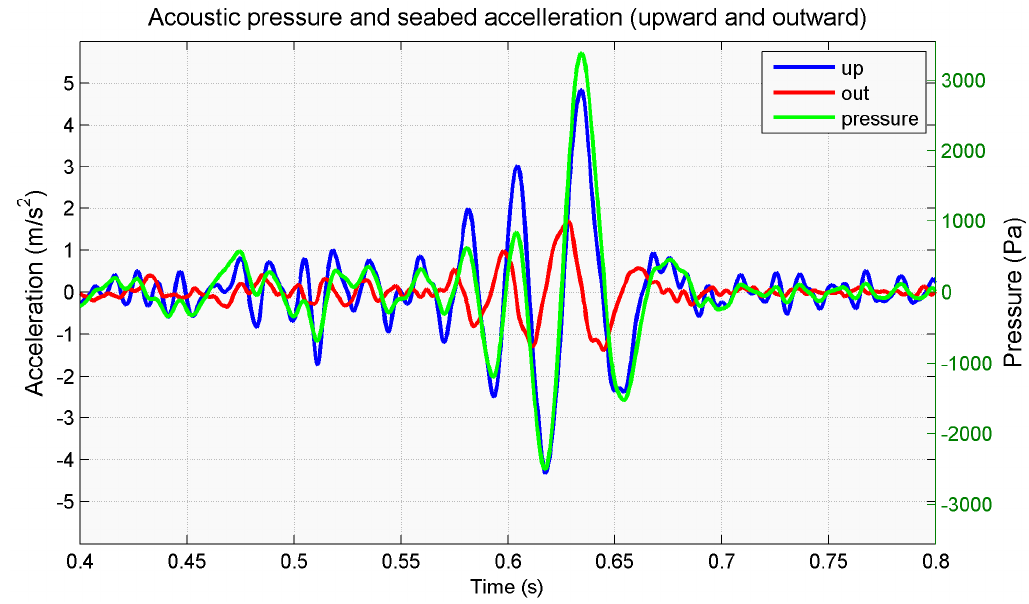
Figure 11. A time series of motion and acoustic pressure at the interface.